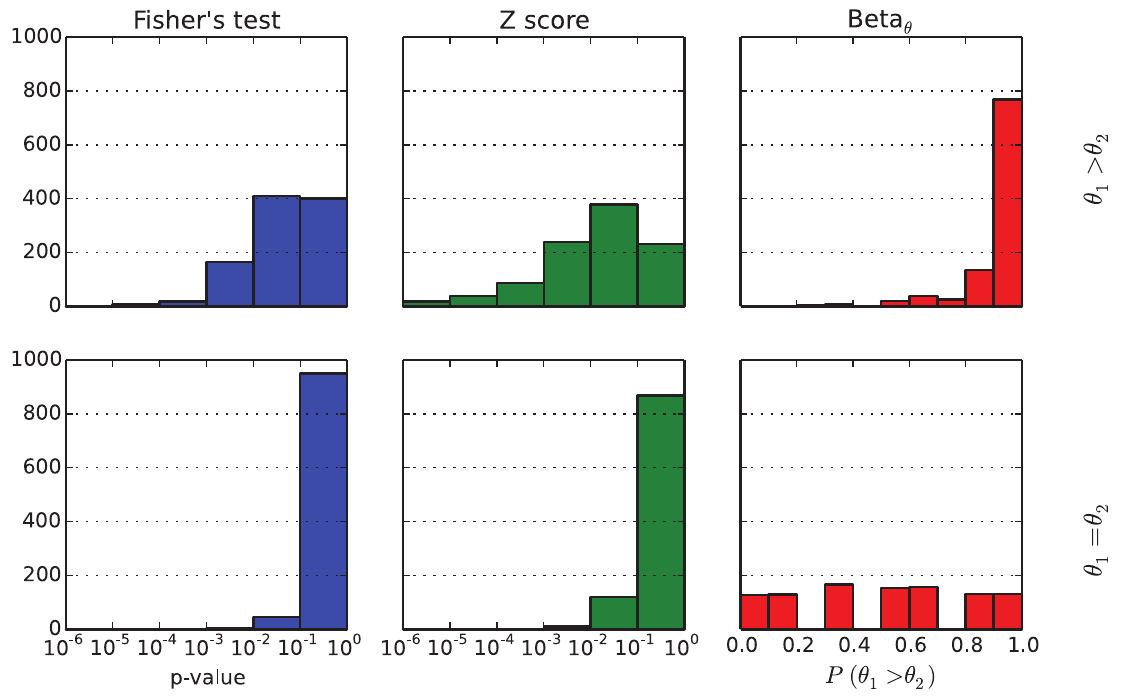
Figure 3. Distribution of p-values (for the hypothesis tests discussed) and of P ( h 1 w h 2 ) computed with the Beta h model. The first row depicts the truly different samples ( h 1 ~ 0 : 9, h 2 ~ 0 : 5 ). The bottom row refers to the control samples. For all the plots d 1 ~ 10, d 2 ~ 10 .